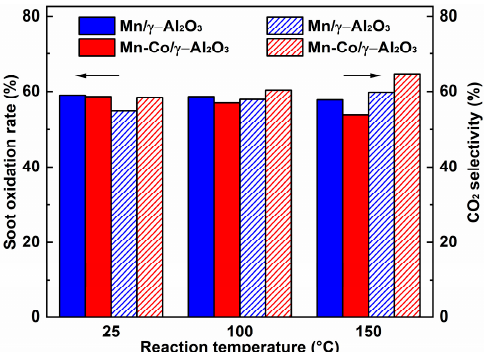
Figure 8. Effect of reaction temperature on plasma–catalytic soot oxidation at 30th min over Mn- Co/ γ -Al 2 O 3 and Mn/ γ -Al 2 O 3 catalysts (discharge power: 14 W, reaction time: 30 min, oxygen content: 10 vol.% and gas flow rate: 500 mL·min − 1 ).